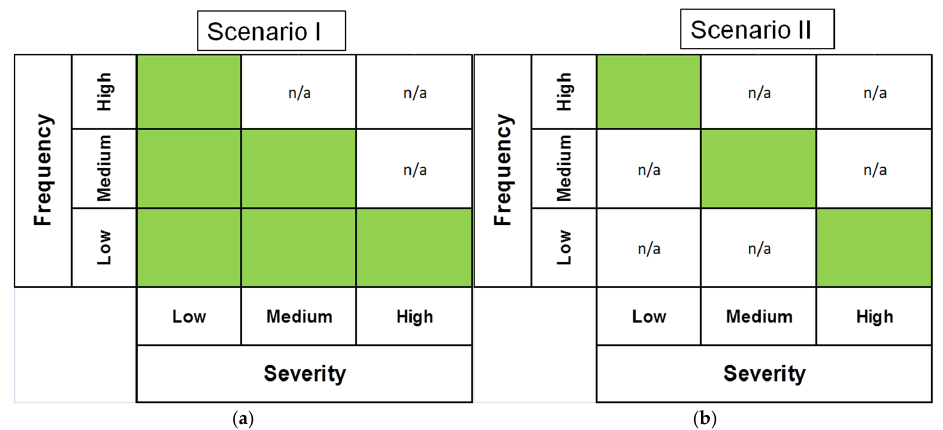
Figure 2. Matrix visualization of the split between loss frequency and loss severity in Scenario (I) and (II): ( a ) The left panel shows Scenario (I) splitting high/medium/low severity → high/medium/low frequency ( one ‐ to ‐ many map) ( b ) The right panel shows Scenario (II): high/medium/low Severity → high/medium/low frequency ( one ‐ to ‐ one map). Note, the n/a represents that no relationship exists in that quadrant of the matrix.